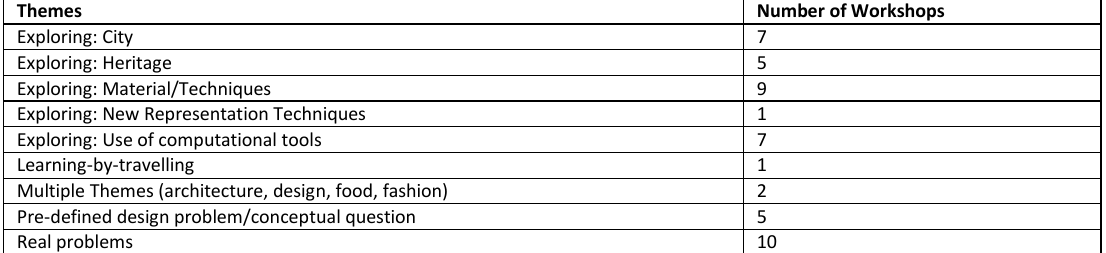
Table 12 Tables representing the number of workshops across ISAD tactics: Themes Themes Number of Workshops